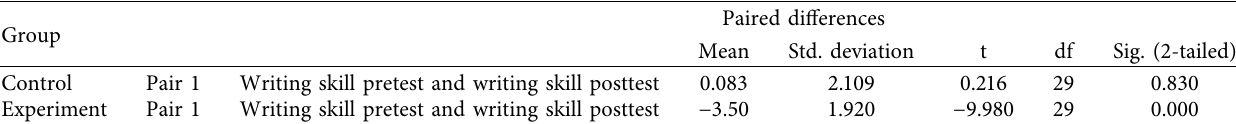
Table 22: Paired-sample